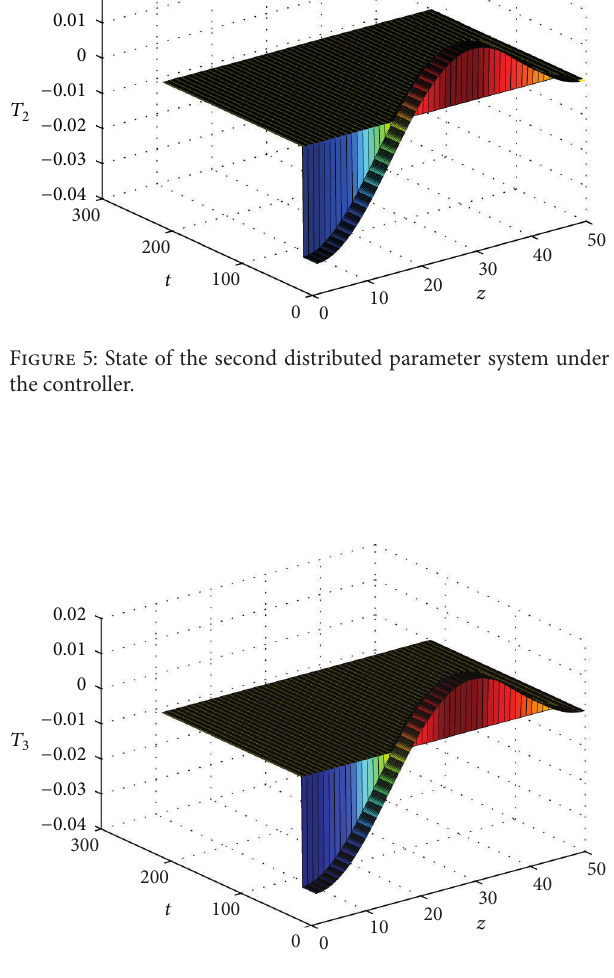
Figure 6: State of the third distributed parameter system under the